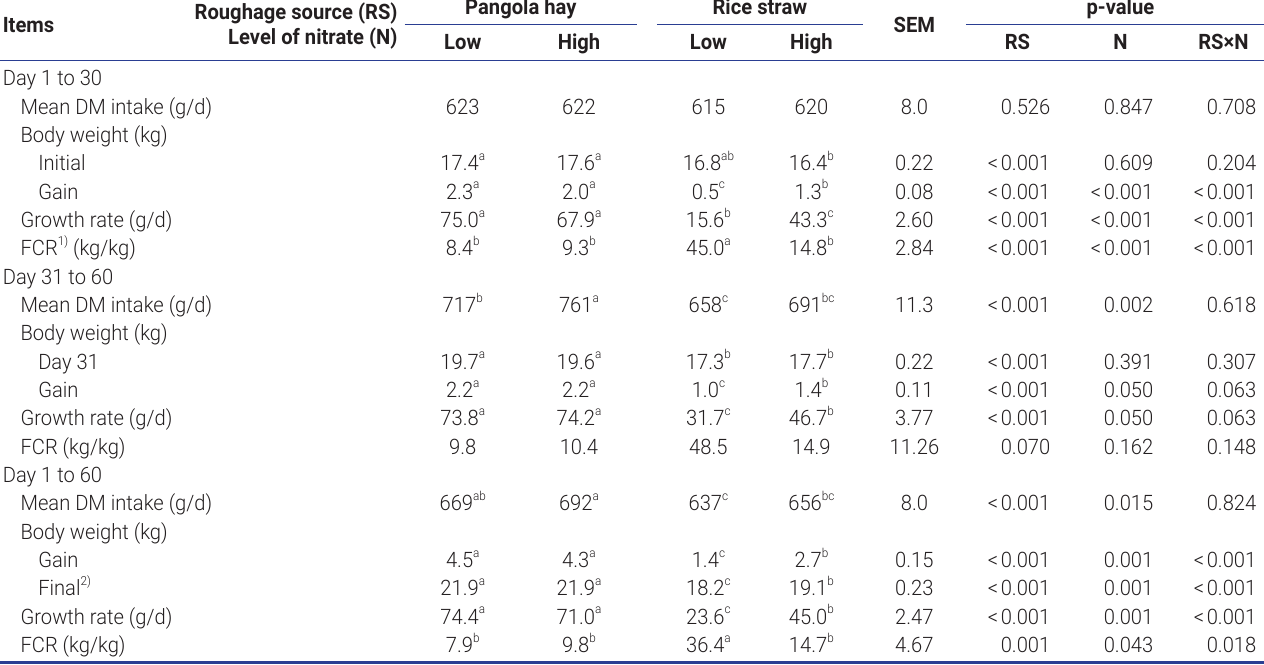
Table 3. Feed intake and growth performance in goats after the feeding of the experimental rations for 60 days Roughage source (RS) Items Level of nitrate (N)